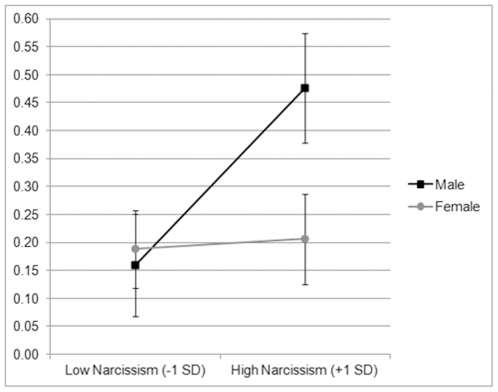
Raw cortisol concentrations of men and women who were low (−1 SD) and high (+1 SD) in narcissism (standard errors in parentheses).